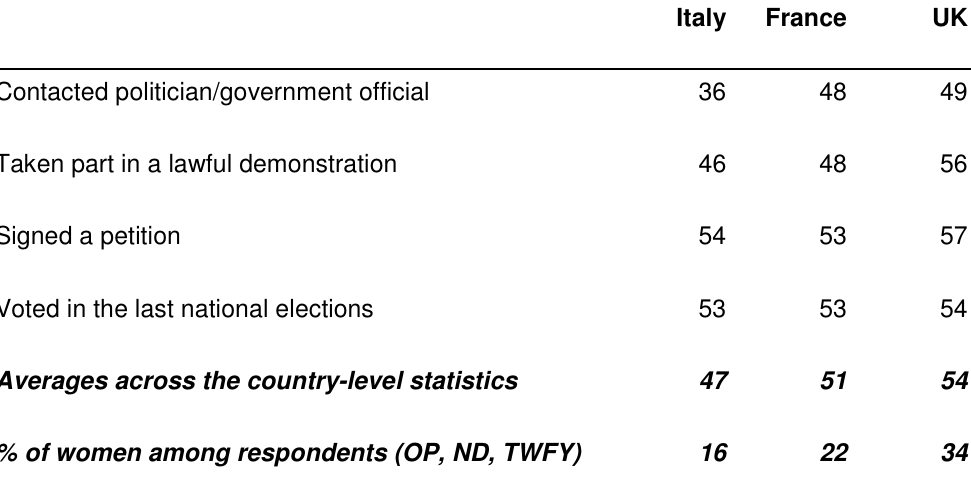
Table 1: Percentages of politically active women in Italy, France and the UK (Author’s surveys 2011, Escher 2011; European Social Survey (ESS) ESS1-2002 4 ; United Nations Statistics Division 2012) 5